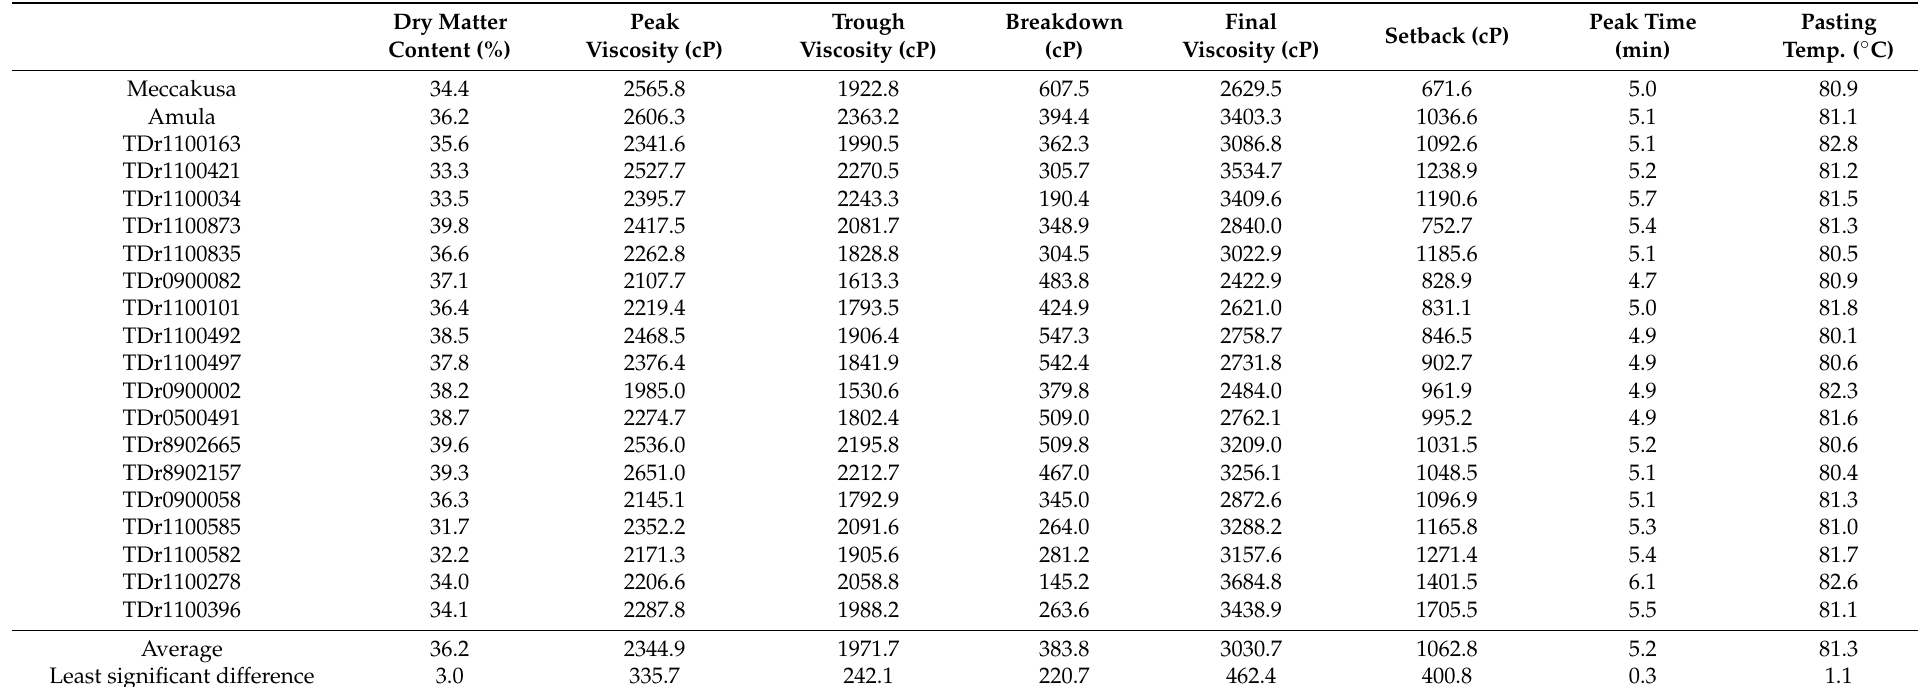
Table 4. Best linear unbiased prediction values of tuber dry matter content and starch pasting properties in twenty Dioscorea rotundata genotypes grown in three different locations in